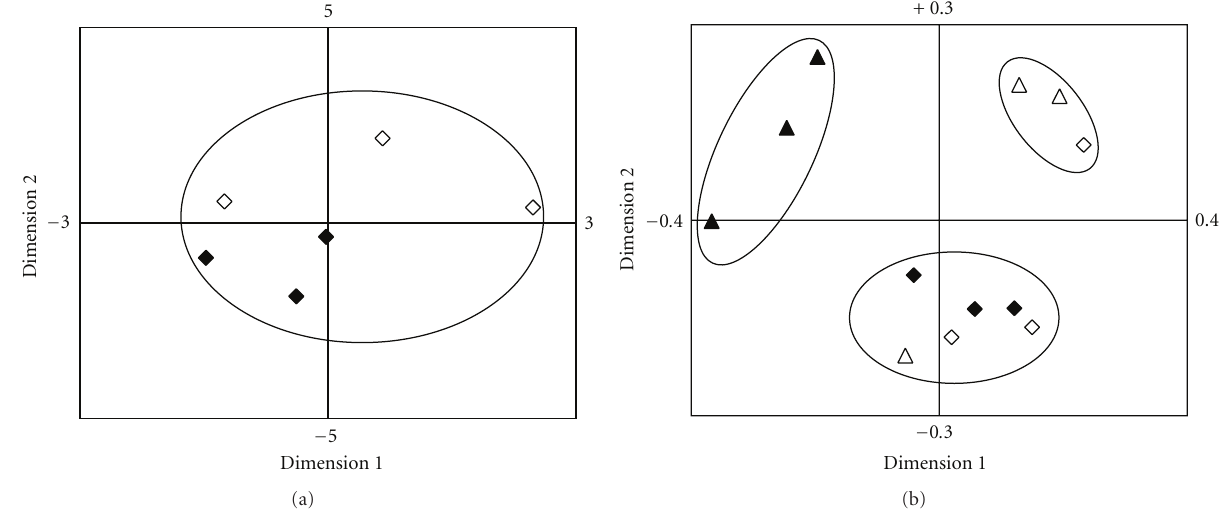
Figure 4: Ordination plots DGGE data from organic farm market garden soils in (a) June and (b) August. Stress of the plot = (a) 0.013 and (b) 0.13. Symbol designations are as described in Table